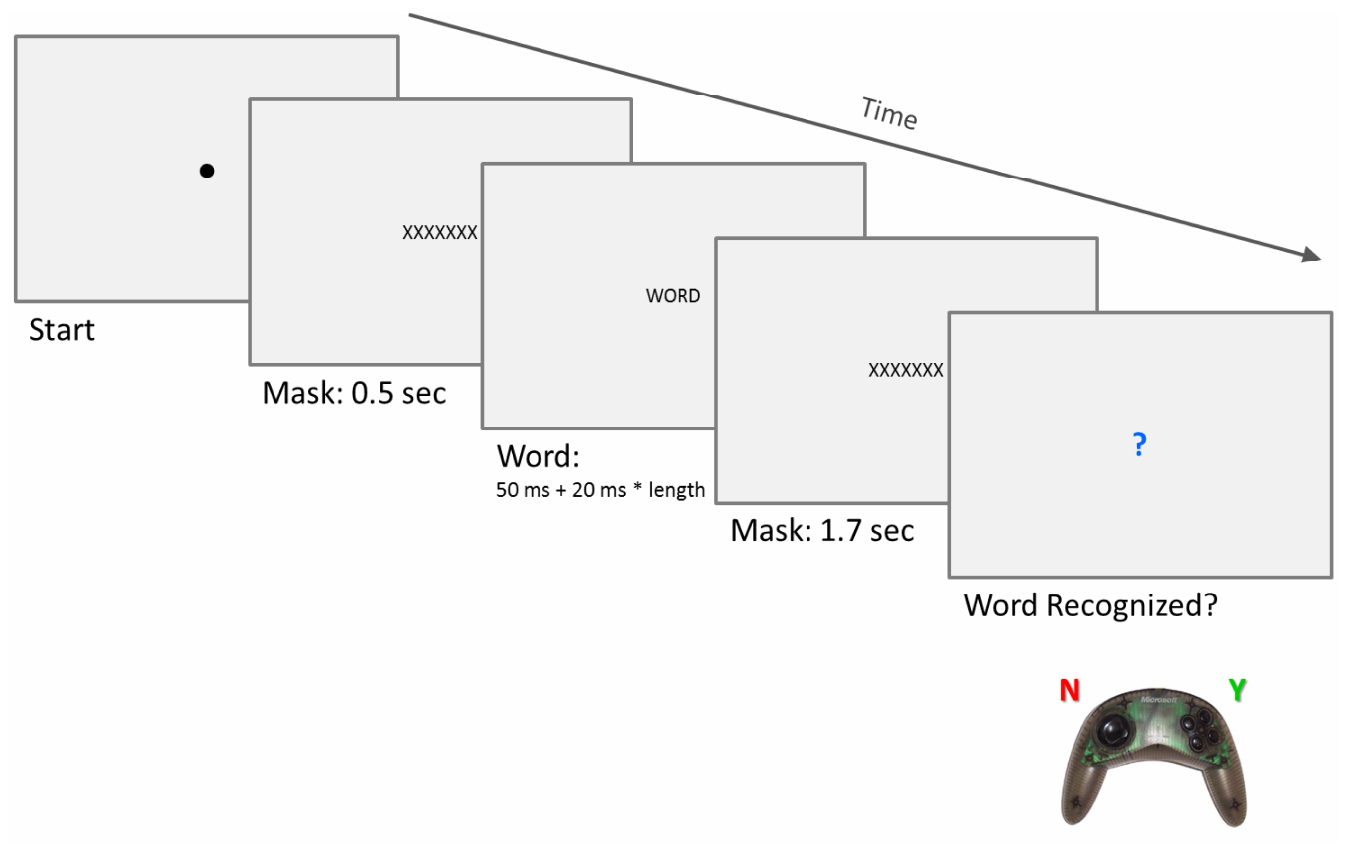
Fig 1. Presentation sequence per